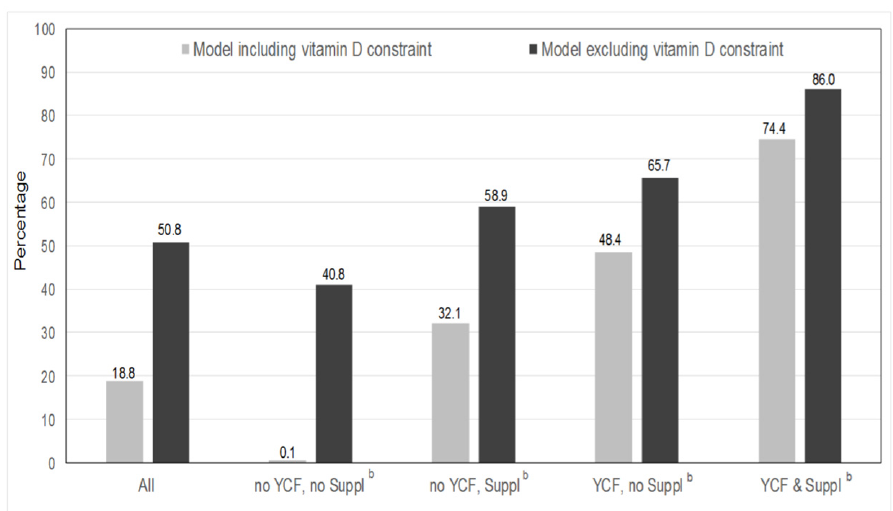
Figure 1. Percentage of children for whom it was feasible to model a nutritionally ‐ adequate diet with their repertoire ‐ foods only for the whole sample and across the four groups of children with and without vitamin D constraint a,b . a Significant ( p < 0.01) associations were observed between the percentage of feasibility and groups of children whatever the model (i.e., with and without the vitamin D constraint), with and without adjustments for age and energy (using logistic regression and chi ‐ squared tests, respectively); b “no YCF, no Suppl” refers to children who did not consume either YCFs or supplements during the four days of dietary record; “no YCF, Suppl” refers to those who did not consume YCFs, but who consumed supplements; “YCF, no Suppl” refers to those who consumed YCFs, but not supplements; “YCF & Suppl” refers to those who consumed both YCFs